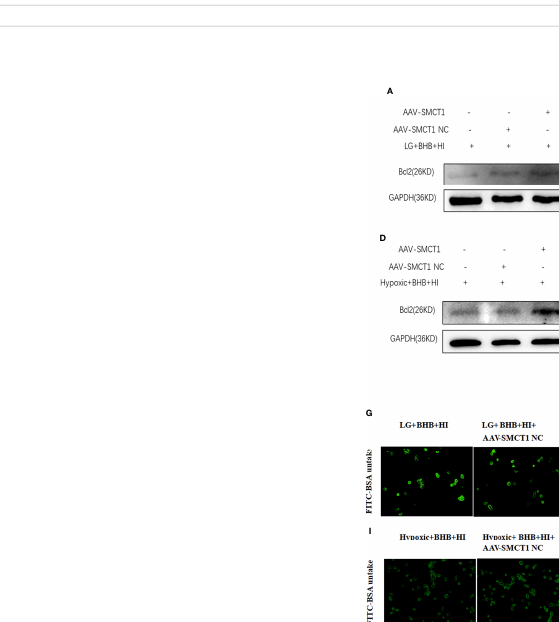
FIGURE 11 High insulin level inhibited BHB-induced protection on mitochondrial function in HK2 cells under low glucose or hypoxic conditions through SMCT1 in HK2 cells. (A, D) Validation of overexpression of SMCT1; (B, C, E, F) Expression of PGC1 a , Mfn1, and Drp1 in HK2 cells under overexpression of SMCT1; (G – I) ATP production in different groups. In panels (A, C, G, H) a p < 0.05, compared with the LG + BHB + HI group (control group); b p < 0.05, compared with the LG + BHB + HI + AAV-SMCT1 NC group (vector group); in panels (D, F, I) a p < 0.05, compared with Hypoxic + BHB + HI group; b p < 0.05, compared with the Hypoxic +BHB + HI + AAV-SMCT1 NC group.